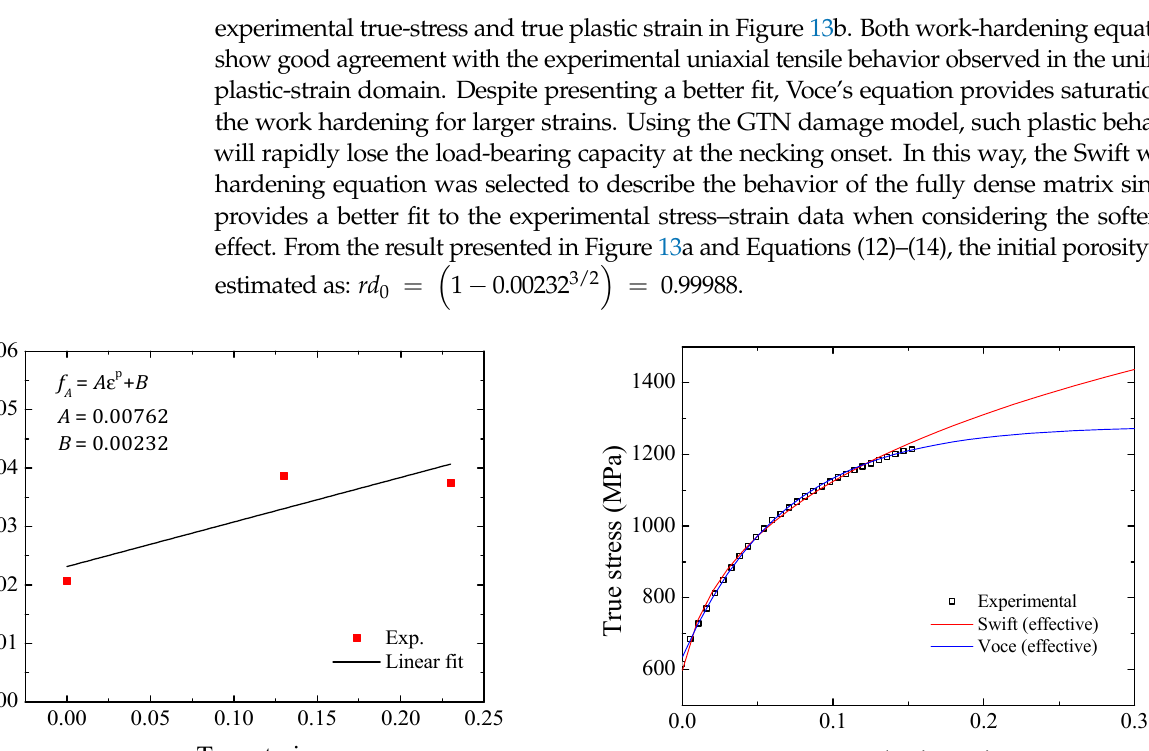
( b ) Figure 12. Void analysis results: ( a ) void density and void area fraction, ( b ) void aspect ratio and mean void size.